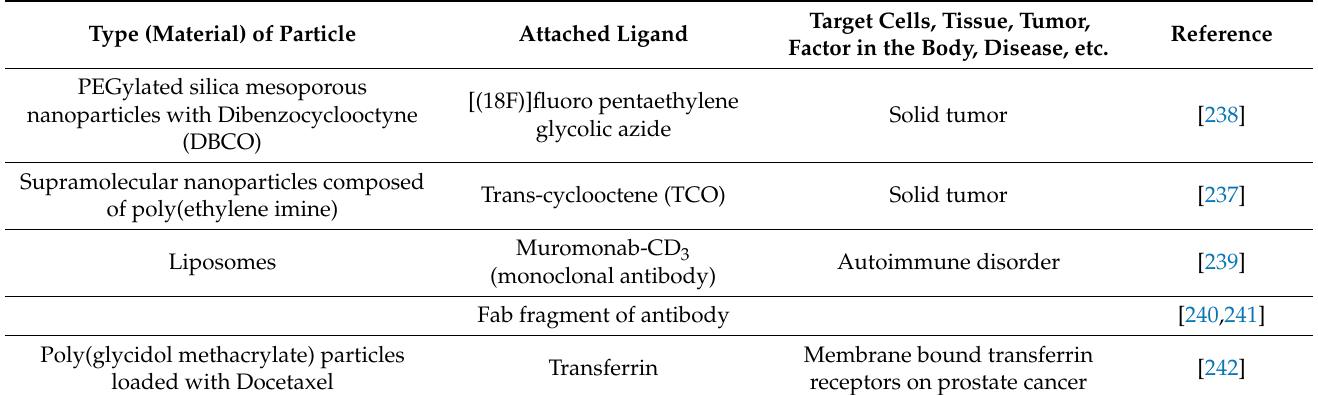
Target Cells, Tissue, Tumor, Factor in the Body, Disease,